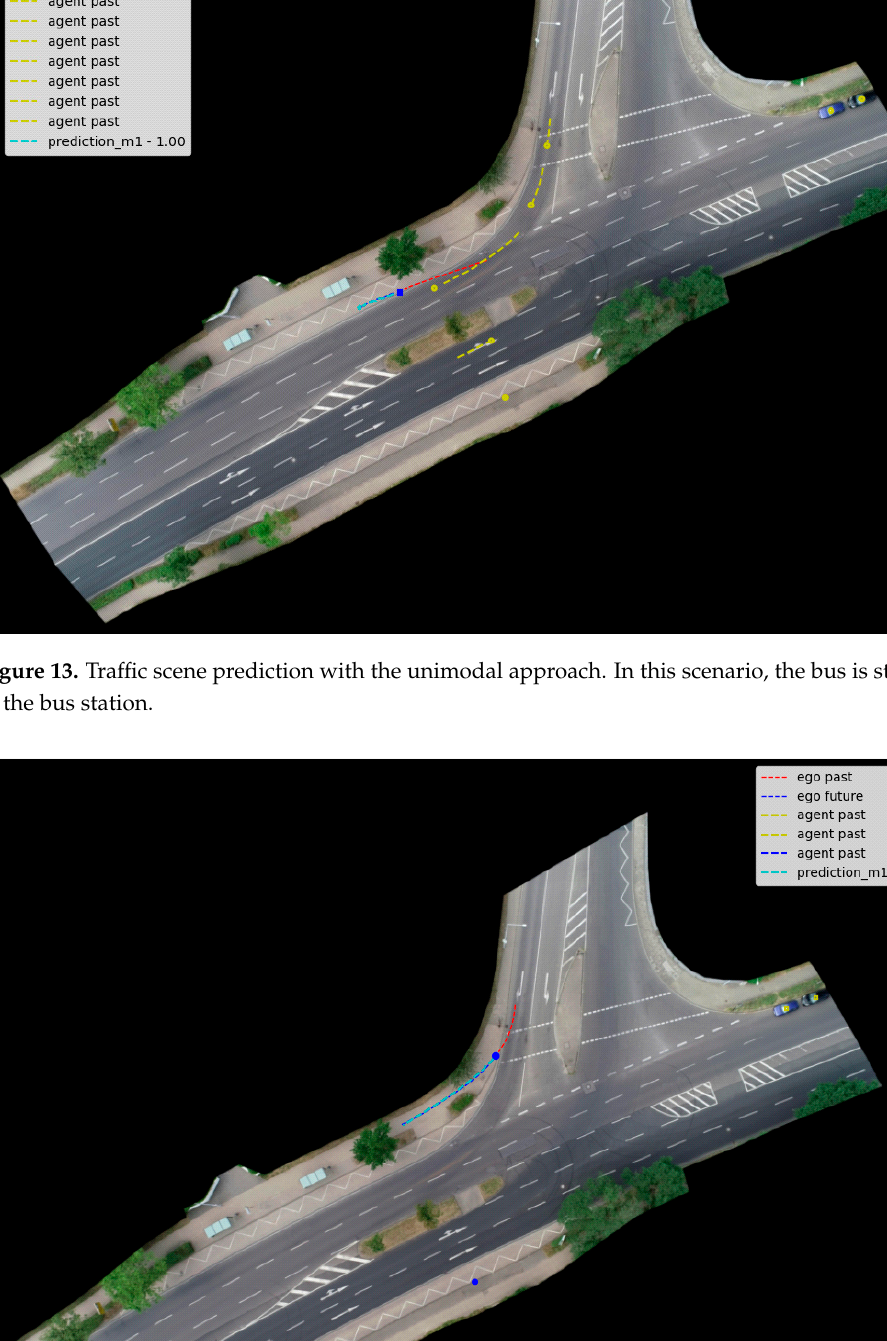
Figure 12. Tra ffi c scene prediction with the unimodal approach. In this scenario, the car is changing the lane.